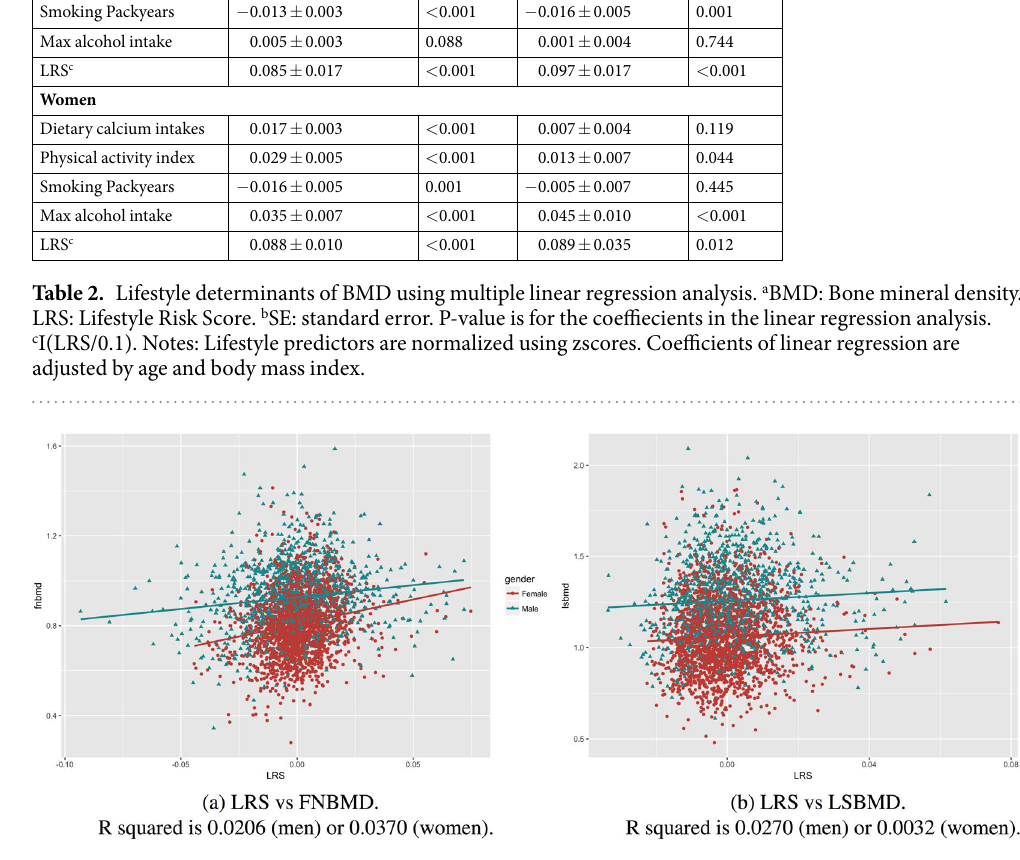
Figure 2. Lifestyle Risk Score (LRS) against femoral neck BMD (FNBMD) and lumbar spine BMD (LSBMD). R squared values are reported from corresponding linear regression estimations. The models were note adjusted for age and BMI. ( a ) LRS vs FNBMD. R squared is 0.0206 (men) or 0.0370 (women). ( b ) LRS vs LSBMD. R squared is 0.0270 (men) or 0.0032